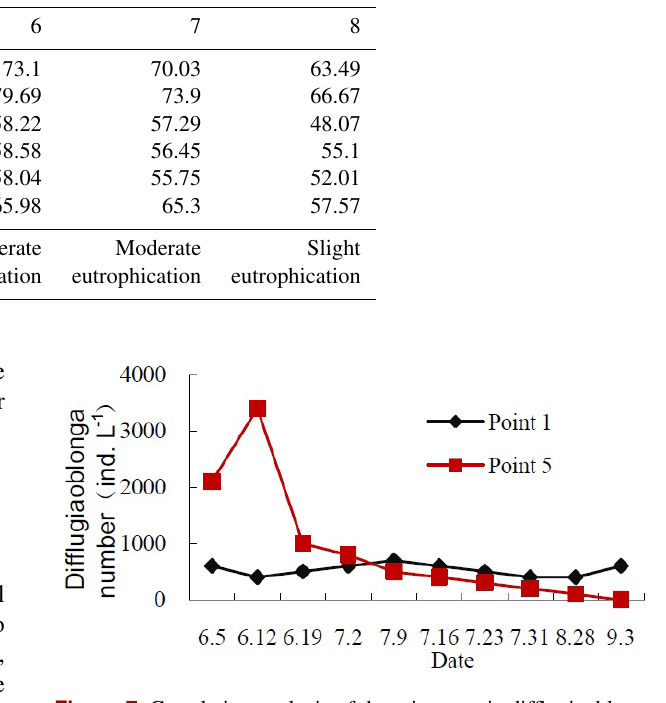
Figure 7. Correlation analysis of the microscopic difflugiaoblonga